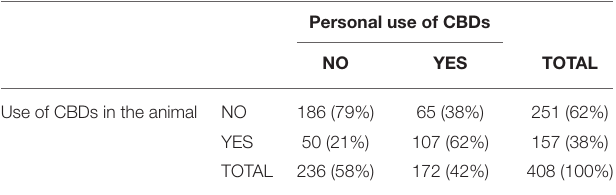
TABLE 3 | Descriptive statistics for postmodern health values a . Subscales